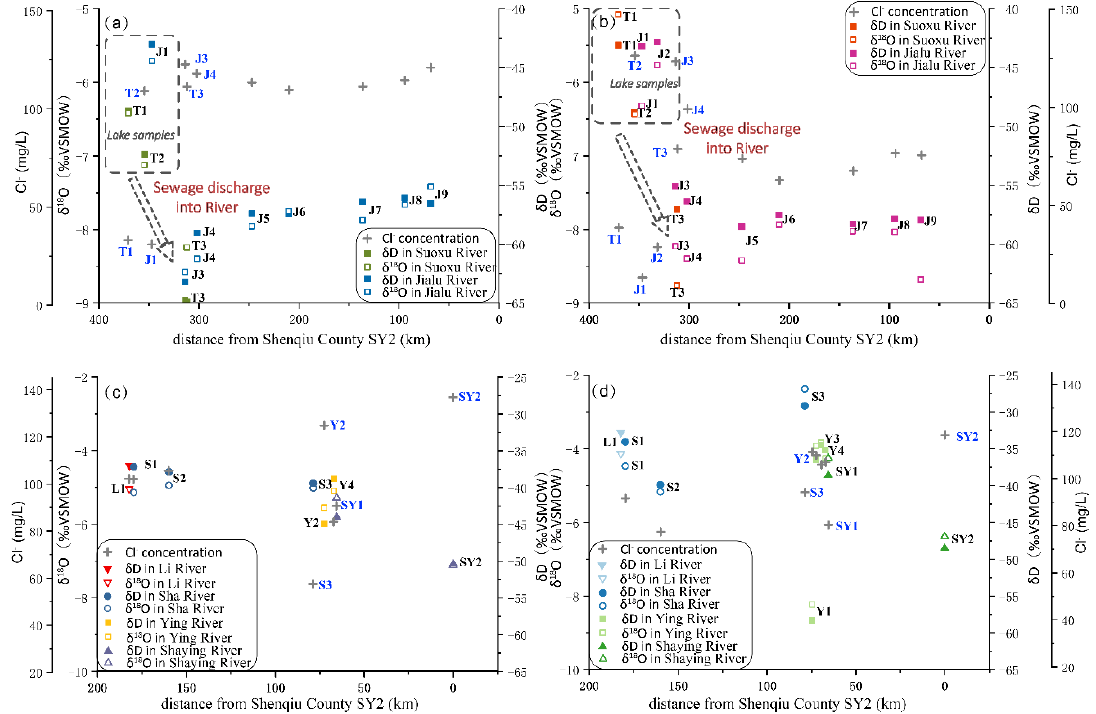
Figure 10. The distance from SY2 (Shenqiu county) profiles for chloride, stable isotopes δ D, and δ 18 O in the ( a ) Jialu River in the dry season, ( b ) Jialu River in the wet season, ( c ) Shaying River in the dry season, and ( d ) Shaying River in the wet season.